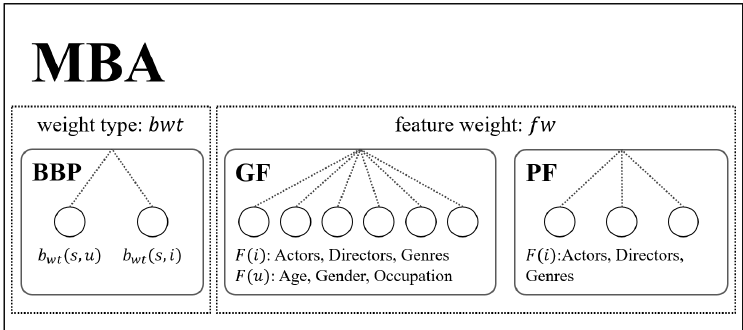
Figure 2. Description of MBA’s heuristics